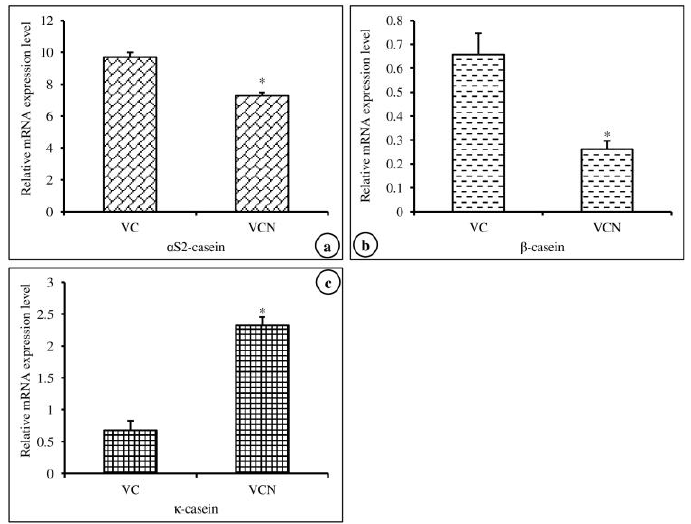
Figure 6. Effect of nanoemulsion-free vit-C (VC) and nanoemulsified vit-C (VCN) on casein gene expression in MAC-T cells as evaluated by quantitative RT-PCR. The nanoemulsified vit-C had inhibitory effects on α s2 - ( a ) , β - ( b ) , and κ -casein ( c ) expression and stimulatory effects on κ -casein expression when compared with the non-nanoemulsified vitamins, as the average (±SEM of the average) of three independent experiments.